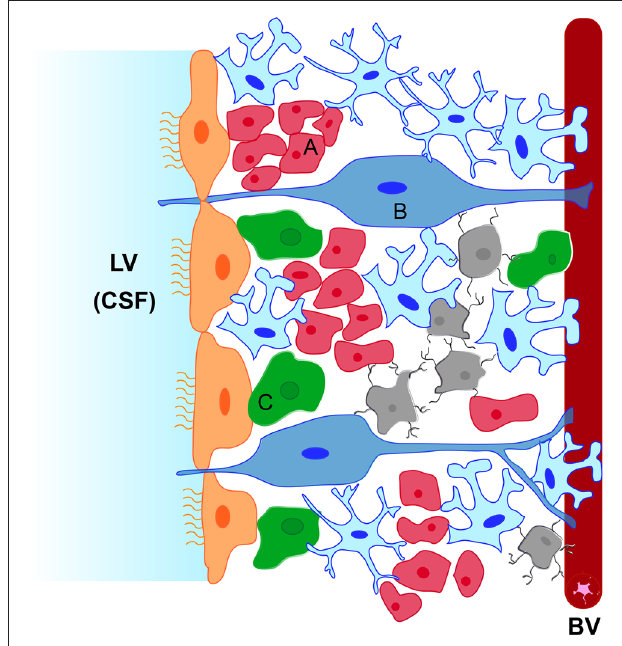
FIGURE 1 | Schematic representation of the subventricular zone (SVZ) neurogenic niche. The niche is located underneath the ependymal cells (in orange) lining the lateral ventricle (LV). It is constituted by type B neural stem cells (in blue, B) which can activate and generate type C neural progenitor cells (NPCs; in green, C) that proliferate rapidly and generate type A neuroblasts (in red, A). Type B cells extend a short apical process to contact the cerebrospinal fluid (CSF) and a long basal process that terminate on blood vessels (BVs). Astrocytes (in pale blue) contact BVs, ependymal cells and type C cells and surround migrating neuroblasts towards the olfactory bulb. Microglial cells (in gray) contact type A, type B and type C cells and also